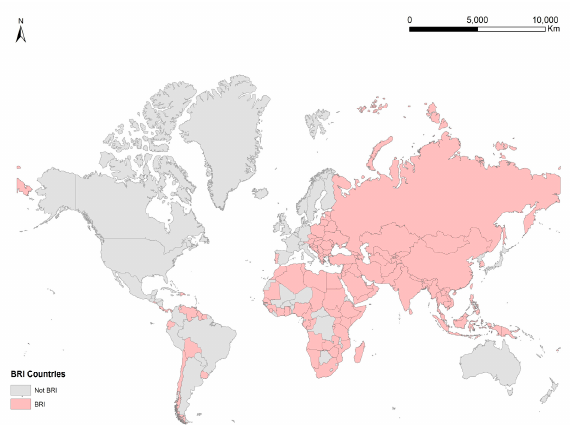
Figure 1. Study area: 128 countries or regions in the region of the “Belt and Road Initiative” (BRI).